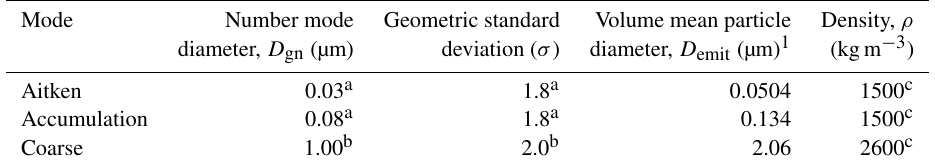
Table 1. Short summary of major differences between BAM-Fe and MIMI. BAM-Fe (CAM4) MIMI (CAM5) Externally mixed bulk aerosol tracers with four size Internally mixed two-moment aerosol tracers with three bins (0.1–1.0, 1.0–2.5, 2.5–5.0, 5.0–10.0µm) aerosol iron size modes (Aitken, accumulation, coarse) Static soil erodibility from offline maps: DEAD (Zender Time-varying soil erodibility calculated online: Kok et et al., 2003) scheme al. (2014a) scheme Eight dust minerals, five of which are iron bearing No change Static Luo et al. (2008) combustion iron emissions Static Luo et al. (2008) combustion iron emissions × 5 Static Luo et al. (2008) fire iron emissions Time-varying Fe:BC fire iron emission ratio Surface fire iron emissions Vertically distributed fire iron emissions Static aerosol pH across aerosol size bins Aerosol pH size dependent Assumed oxalate concentration based on primary or- Assumed oxalate concentration based on secondary or- ganic carbon ganic carbon In-cloud aerosol concentrations based on simulated Separate in-cloud and interstitial aerosol tracers cloud fraction Table 2. Combustion iron aerosol size and number properties. Mode Number mode Geometric standard Volume mean particle Density, ρ